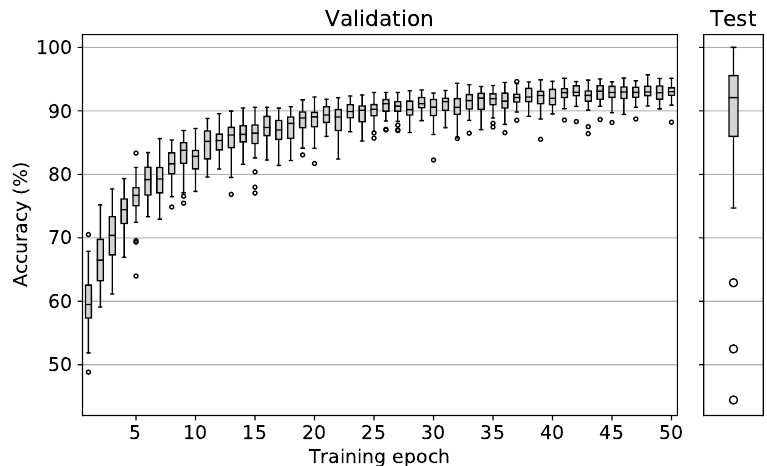
Figure 6. Left: Validation accuracy after each epoch of the 34 different models that were trained during the LLTO procedure. Right: Accuracy values reached during testing. Boxes range from the lower to the upper quartile values of the data with a line at the median. Whiskers extend to 1.5 interquartile range. Outliers are marked as